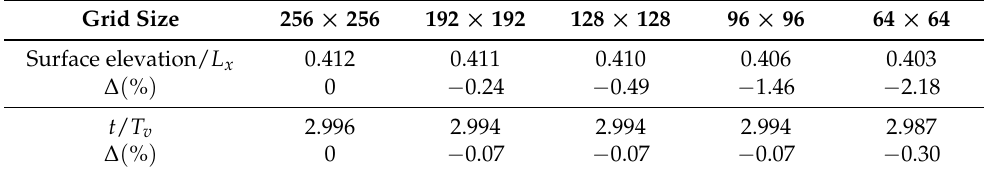
Table A8. Spacial grid sensibility analysis for the nonlinear regime: maximum value of surface elevation/ L x , its time location t / T v , and their relative difference compared to 256 × 256 grid for EbFVM S .